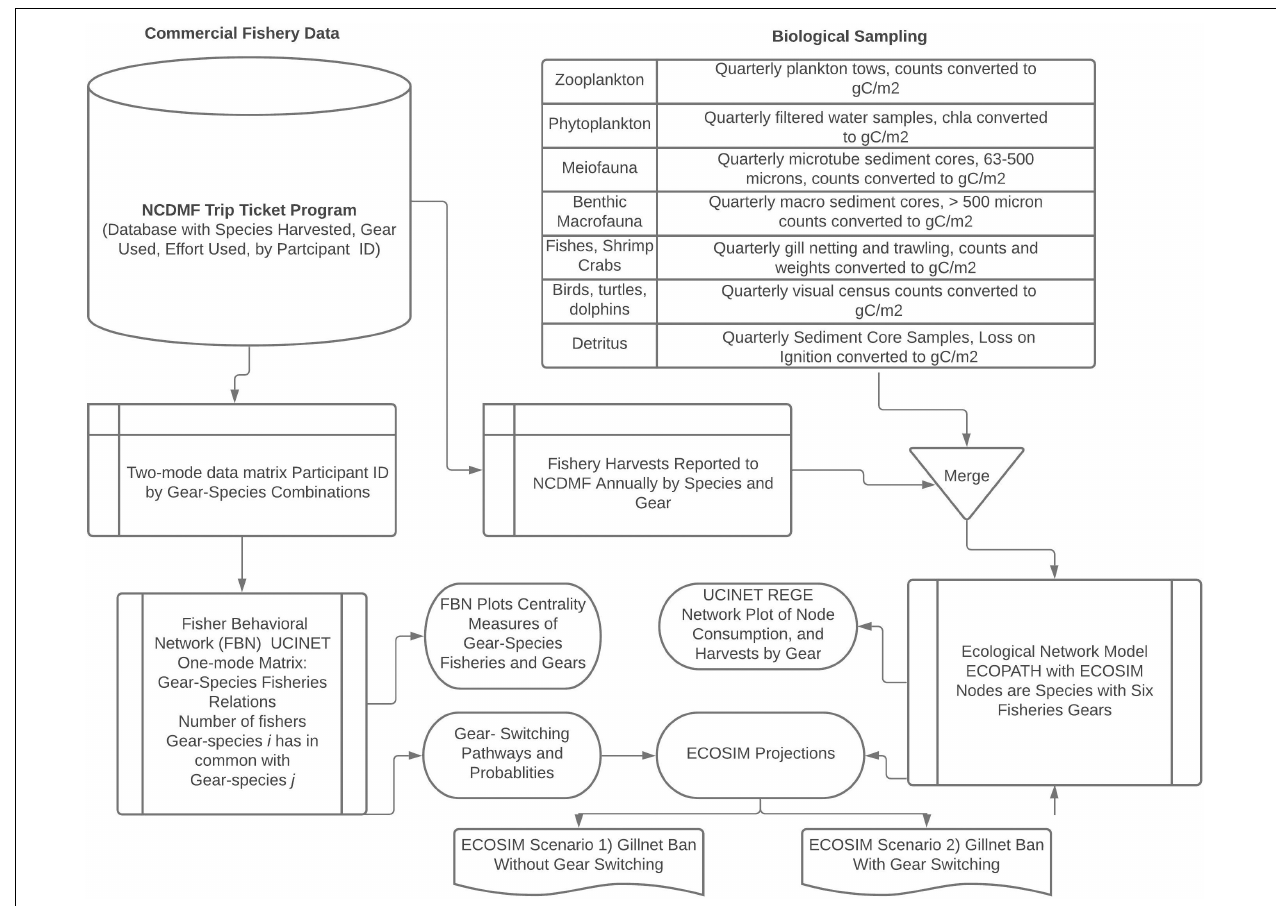
FIGURE 1 | A diagram illustrating the data analysis workflow and manipulations for the analyses in this study. The NCDMF Trip Ticket database is used to store monthly catches reported by licensed fishers in the Core Sound management area, the gear used, the biomass landed, the effort used, the crew involved in the harvest, and the value of the catch. The participants were uniquely identified by a number without revealing their identities to the authors. In addition, according to NCDMF confidentiality protocols, individual fishers’ landings data and dollar values of their catches were not provided to us, only the species landed, and gear used, from which we created the Fisher Behavioral Network. We obtained in a separate datafile the aggregated landings biomass data and dollar values by species and gear used monthly and annually. These harvest data were merged with our own biological sampling to create an ECOPATH model. See Deehr (2012) and Deehr et al. (2014) for detailed methods on the sampling and model development. The Fisher Behavior Network and ECOPATH with ECOSIM were used together to model a gillnet ban with and without gear